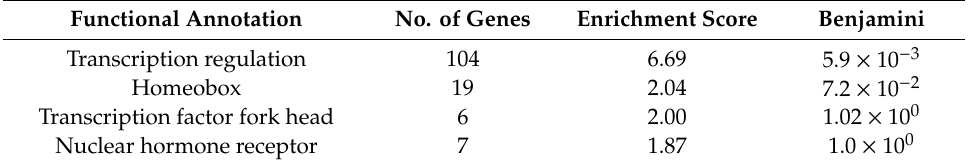
Table 1. Functional annotation up-and downregulated